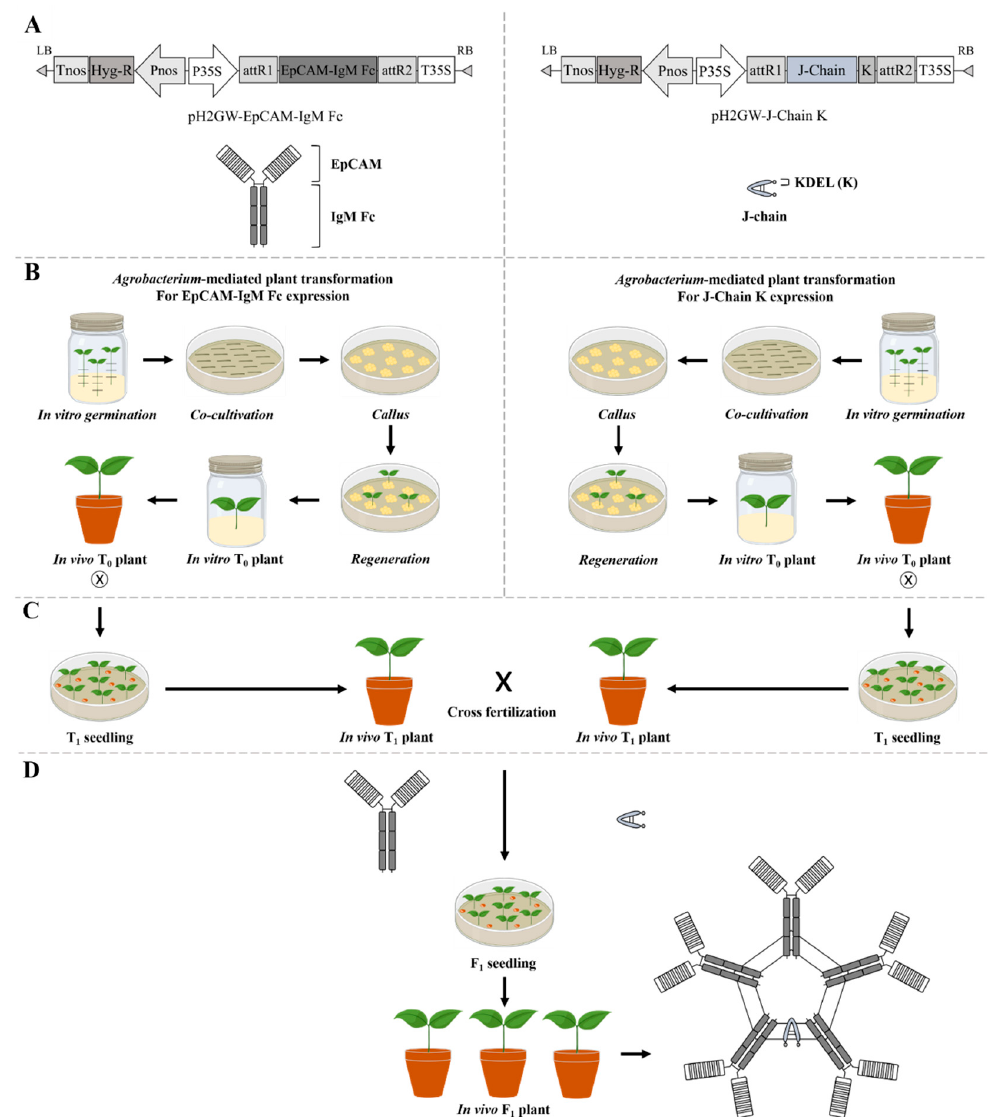
Figure 1. Schematic diagram for Agrobacterium -mediated Chinese cabbage transformation and generation of transgenic plants carrying both epithelial cell adhesion molecule–immunoglobulin M fragment crystallizable (EpCAM–IgM Fc) and Joining (J)-chain K. ( A ) Plant expression vectors to express EpCAM–IgM Fc and J-chain K for Agrobacterium -mediated transformation. The expected quaternary structure of EpCAM–IgM Fc in T 0 transgenic plants carrying the transgene encoding EpCAM–IgM Fc is hexameric. The expected protein structure of the J-chain K in T 0 transgenic plants carrying the transgene encoding J-chain K is hook-like. ( B ) Generation of T 0 transgenic plants carrying EpCAM–IgM Fc and J-chain K obtained from Agrobacterium -mediated transformation. ( C ) T 1 transgenic plants with EpCAM–IgM Fc and J-chain K obtained from self-crossing of T 0 transgenic plants with EpCAM–IgM Fc and J-chain K. Cross-fertilization between T 1 transgenic plants carrying EpCAM–IgM Fc and J-chain K transgenes after selfing of T 0 plant generation. ( D ) F 1 transgenic plants carrying both transgenes encoding EpCAM–IgM Fc and J-chain K obtained from crossing between T 1 transgenic plants carrying transgenes encoding EpCAM–IgM Fc and T 1 transgenic plants carrying transgenes encoding J-chain K. The expected quaternary structure of EpCAM–IgM Fc × J-chain K in transgenic plant F 1 is